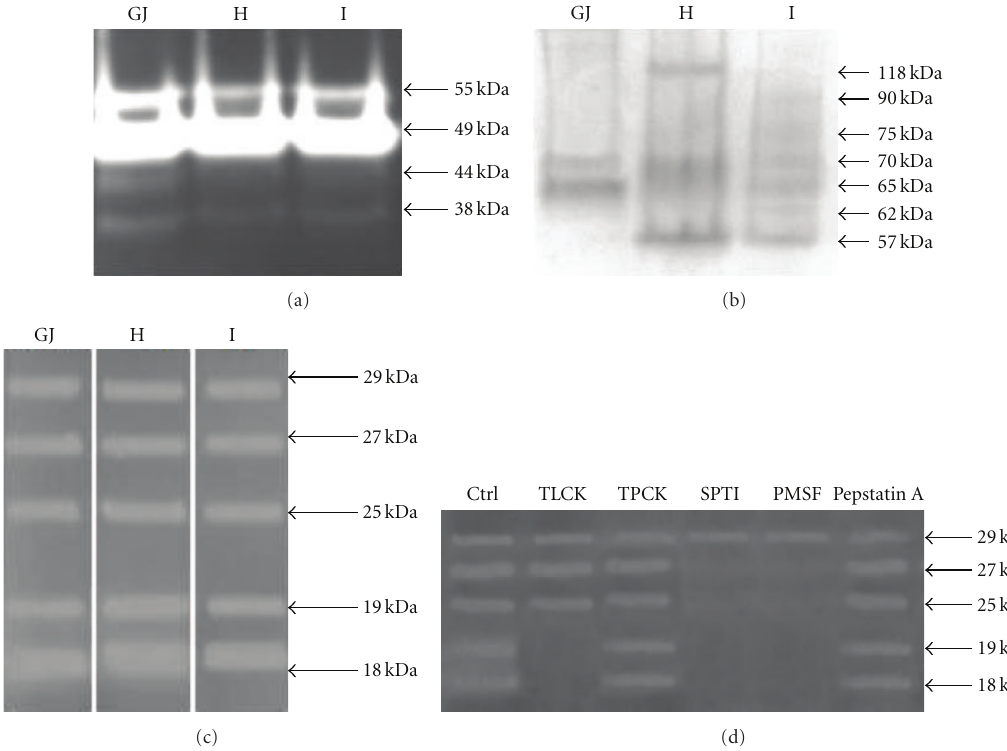
Figure 6: (a) Substrate SDS-PAGE showing amylolytic activity bands of juvenile Cherax albidus . (b) Substrate native-PAGE showing lipase activity bands. (c) Substrate SDS-PAGE showing protease activity bands. (d) Substrate SDS-PAGE showing protease activity bands (Ctrl) and their inhibition by specific inhibitors for trypsin (TLCK), chymotrypsin (TPCK), serine proteases (SBTI and PMSF), and aspartic proteases (pepstatin A). Each zymogram analysis was performed three times on gastric juice (GJ), hepatopancreas (H), and intestine (I) of three independent samples ( n = 3). MW standards are reported on the right. The arrows indicate the active bands and their correspondent apparent molecular